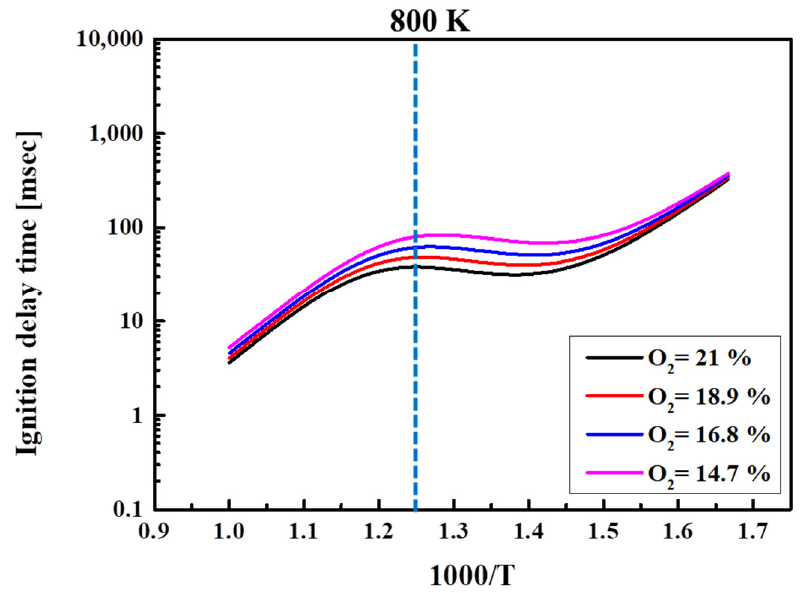
Figure 6. Ignition delay times of blended fuels at Φ = 1.0, P c = 15 bar, CR = 3.5, and O 2 = 21%.